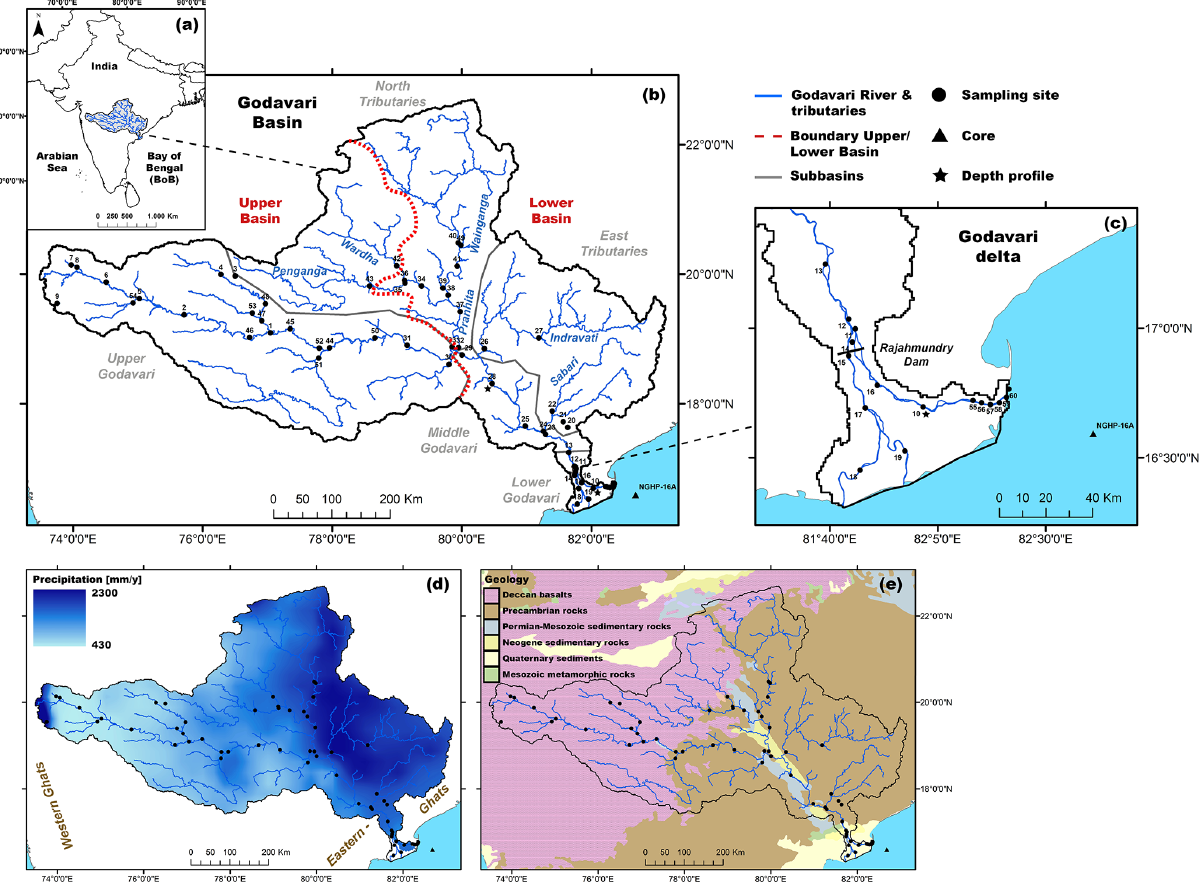
Figure 1. (a) Location of the Godavari River basin in peninsular India. (b) Sampling sites along the river basin, with the different subbasins (grey) and upper and lower basin (red) shown. (c) Zoom for the Godavari delta and the reservoir dam at Rajahmundry. (d) Precipitation across the Godavari basin based on the APHRODITE dataset (Asian Precipitation – Highly Resolved Observational Data Integration Towards Evaluation of Water Resources, V1101 Monsoon Asia) of mean annual precipitation for 30 years at a 0.25 ◦ grid resolution (Yatagai et al., 2012). (e) Geological context of the Godavari